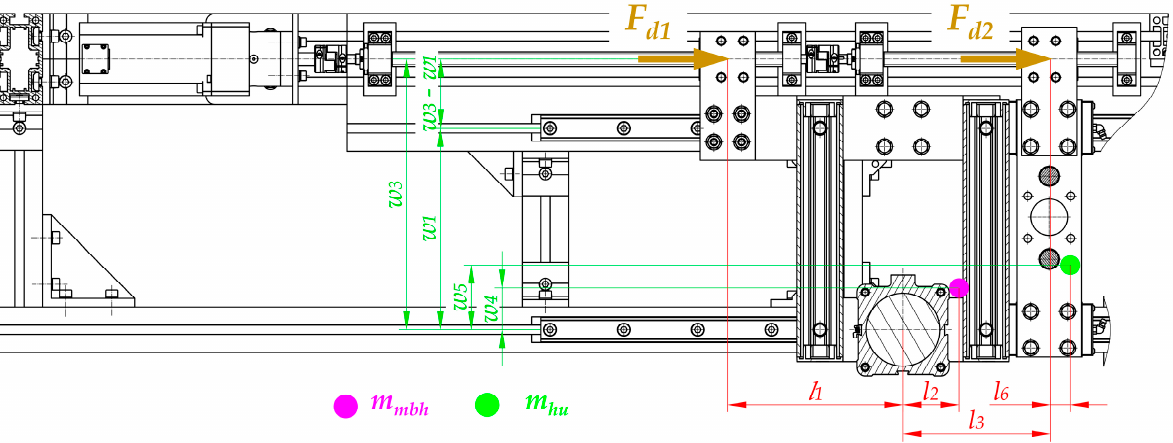
Figure 11. Horizontal section in a plane that is parallel to the linear guideways, of the automated hot plate welder during plasticization, with the particular dimensions necessary for the load state calculations: m mbh —center of mass of the movable belt holder, m hu —center of mass of the heating unit, w 1 …w 5 —particular values of width, l 1 …l 6 —particular values of length, F d 1 —force required to drive the movable belt holder, F d 2 —force necessary to drive the heating unit.